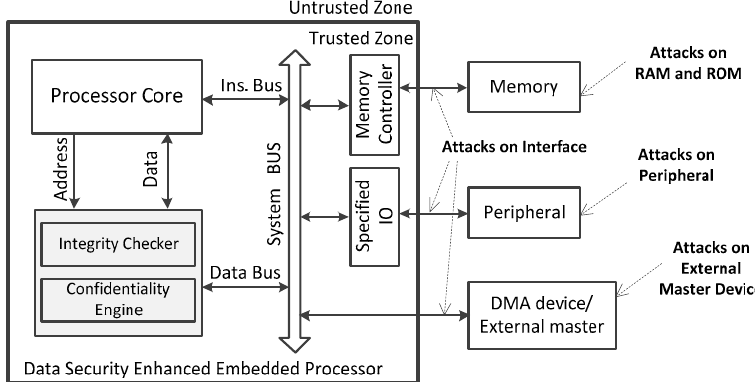
Figure 2. The secure boundary and attacks concerned in this work.